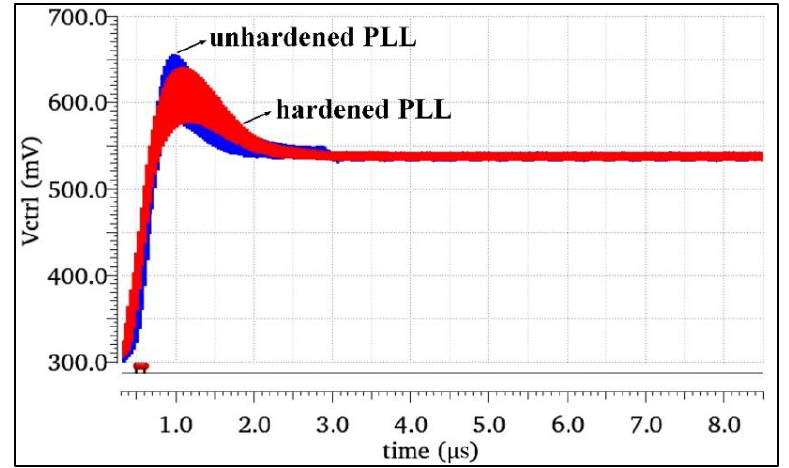
Figure 8. Locking processes of the RHPLL and NHPLL.